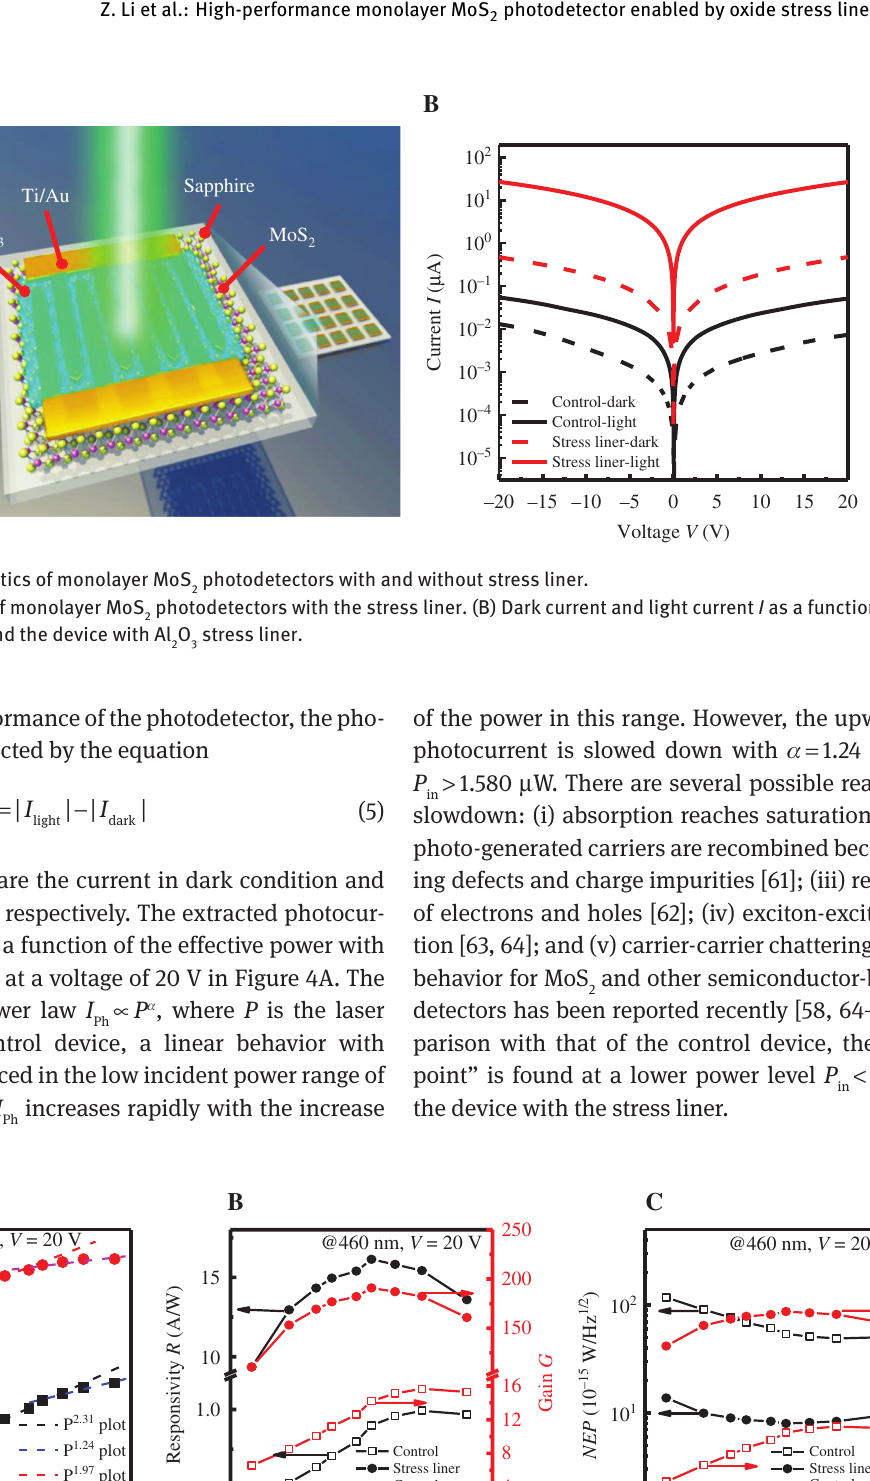
Figure 4: Device characterization under different incident power of monolayer MoS (A) Photocurrent with various incident powers measured for a fixed voltage of 20 V at a wavelength 460 nm.The dashed lines indicate the ∝ P α ) fitting by different α . (B) Performance of control device and the stress liner device as a function of incident power ( P ) power law ( I Ph under a fixed voltage ( V ) of 20 V at 460 nm wavelength. (B) Responsivity ( R ) and photoconductive gain ( G ). (C) Noise-equivalent power (NEP ) and normalized detectivity ( D